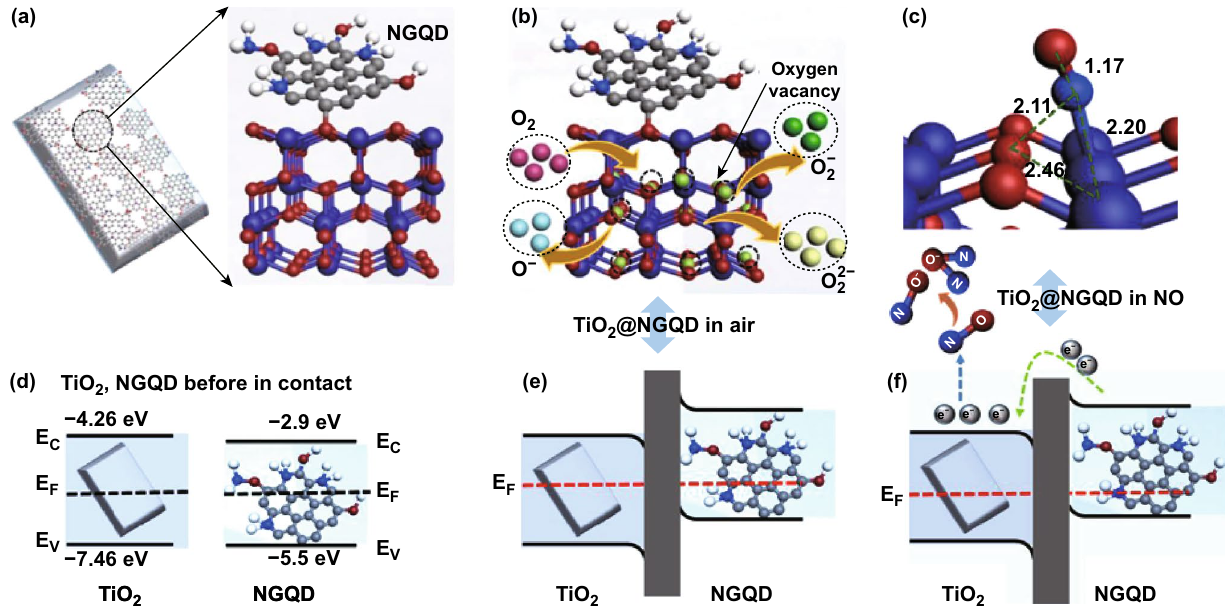
Fig. 7 Schematic sensing mechanism of a TiO 2 @NGQDs hybrids, b O 2 adsorption and conversion to oxygen ion species on TiO 2 {001} sur- face, c NO adsorption on to TiO 2 {001} surface. d Energy band structures of TiO 2 /NGQDs before in contact, and e formation of p–n junction after contact, and f electron transfer in the TiO 2 /NGQDs on exposure to NO. Reproduced with permission [76]. Copyright 2020, American Chemical